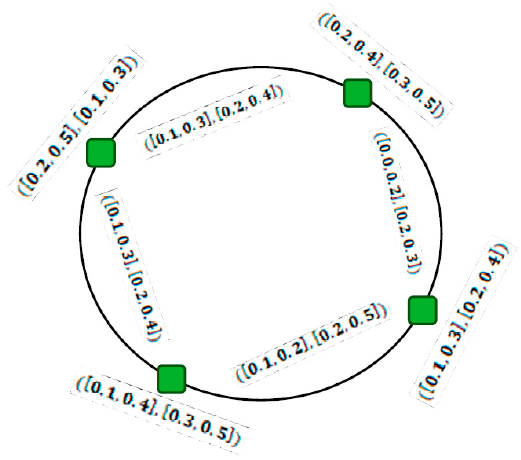
Figure 14. Interval-valued intuitionistic fuzzy graph.